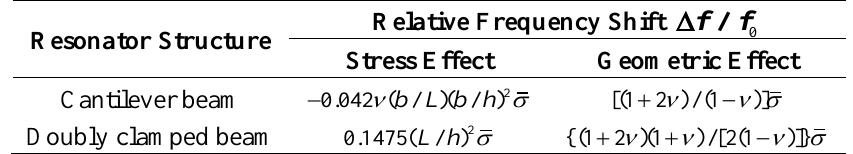
Table 6. Relative frequency shift of cantilever and doubly clamped beam resonators with surface stress and geometric effects reported by Karabalin et al . [203]. A normalized